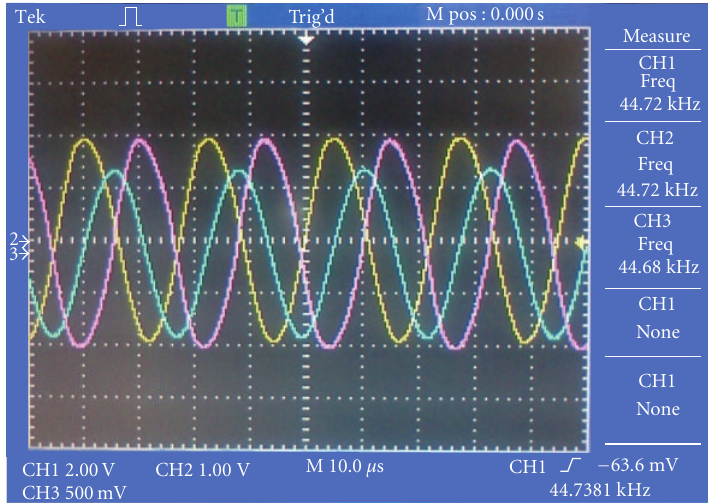
Figure 11: Experimental result for circuit III with two phase shifter